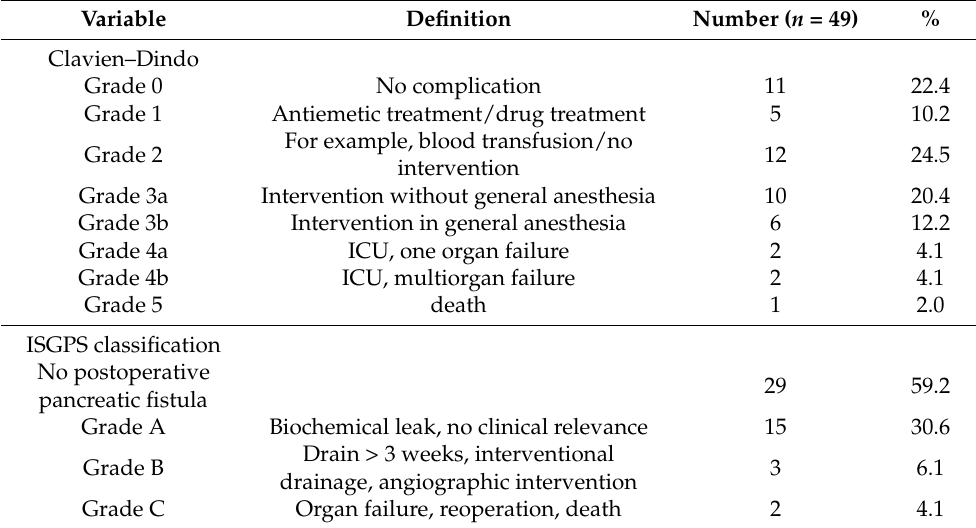
Table 1. Postoperative complications classified according to Clavien–Dindo (CDc) and the Interna- tional Study Group of Pancreatic Surgery